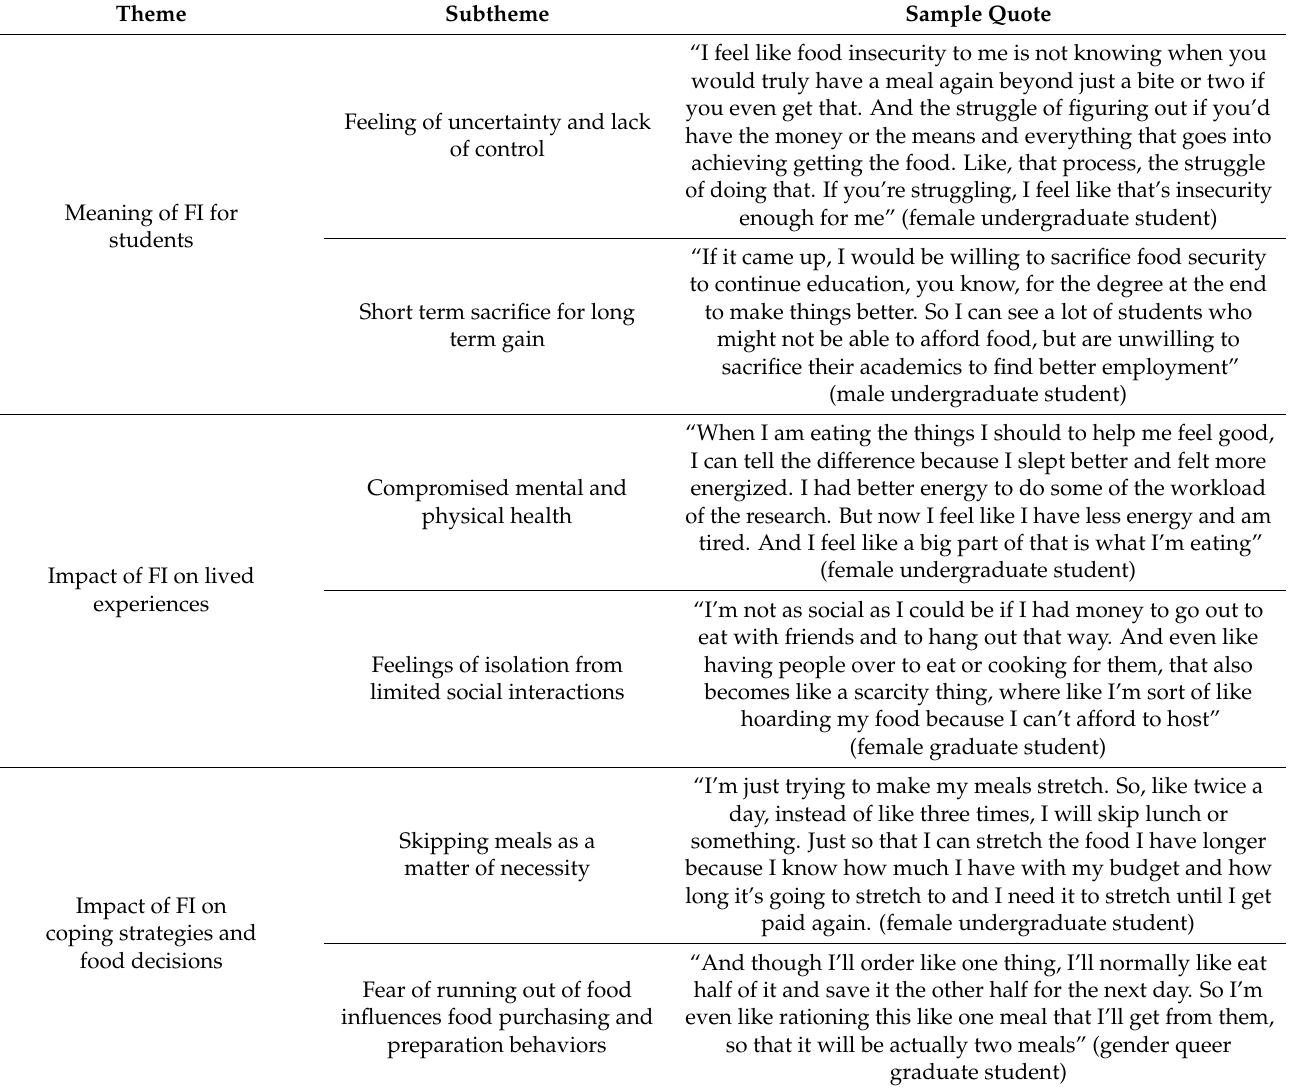
Table 2. Emergent themes and sample quotes related to the meaning of FI and the way it impacts lived experiences and coping strategies and food